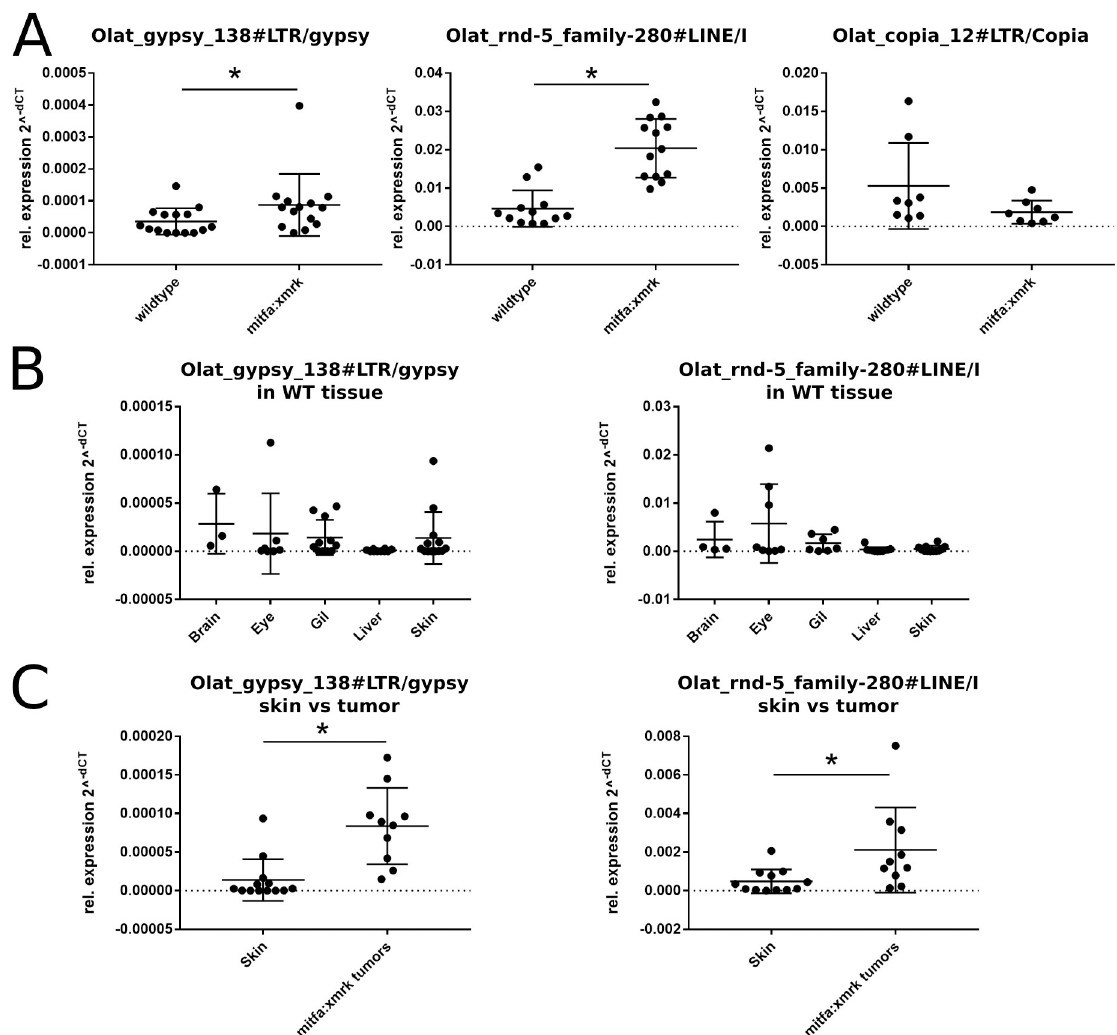
Fig 5. Expression of TEs in larvae and adult tissues. (A) Expression of three TE families in wildtype and transgenic larvae. The higher expression of LTR gypsy 138#LTR and Olat_rnd5_familiy-280_LINE/1 in melanoma developing larvae was confirmed by qRT-PCR. (B) Expression of TE familes in wildtype tissues. (C) Expression of both TE families in skin and melanoma